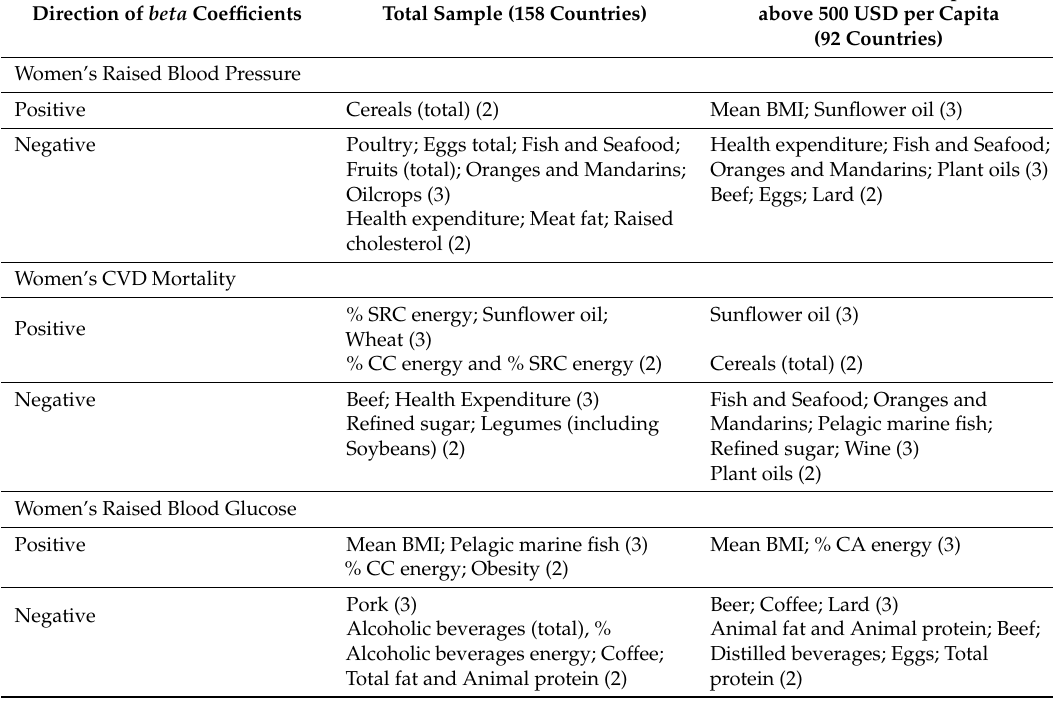
Table 10. Results of three penalized regression models (ridge, LASSO, elastic net) of women’s CVD indicators. Variables are sorted according to the sign of their beta coefficients in the models (positive/negative), and their frequency among the top 10 variables with the highest beta coefficients (in